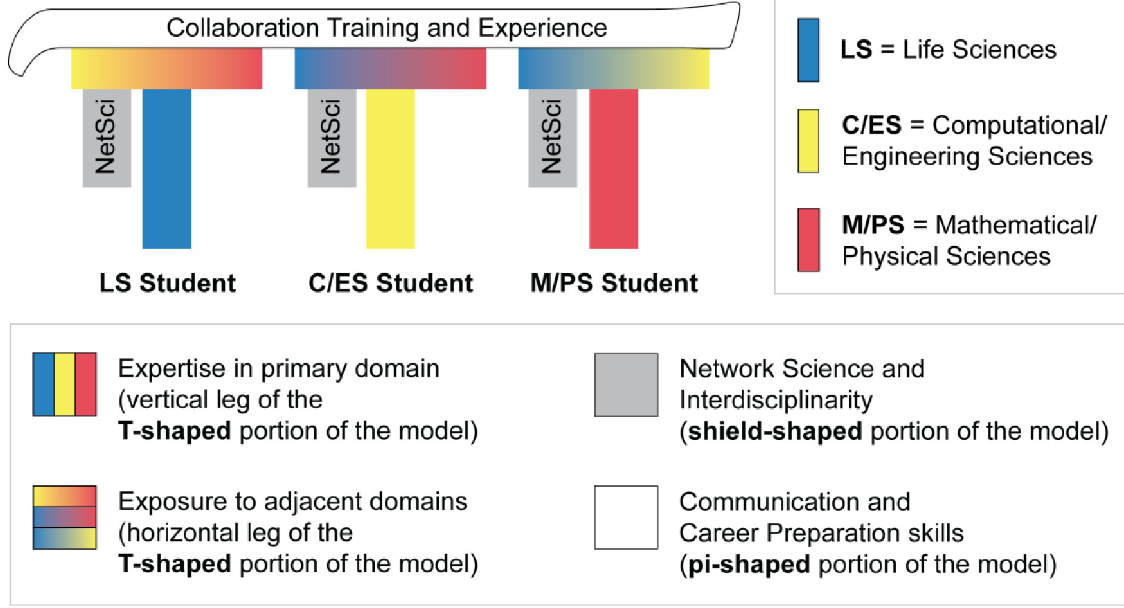
Fig 3. The COMBINE model of integrated interdisciplinary graduate